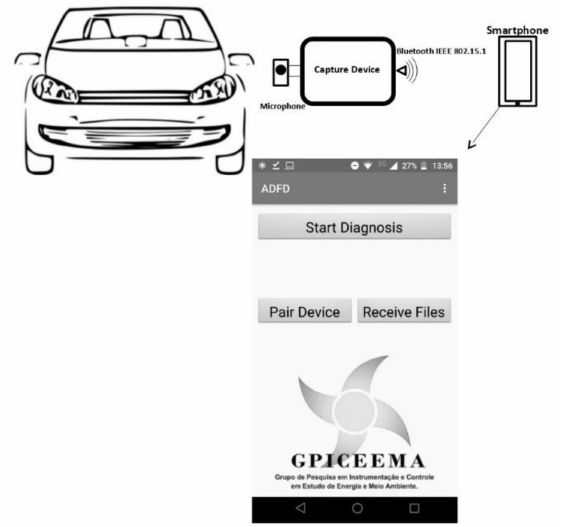
Figure 8. Illustration of the developed system’s